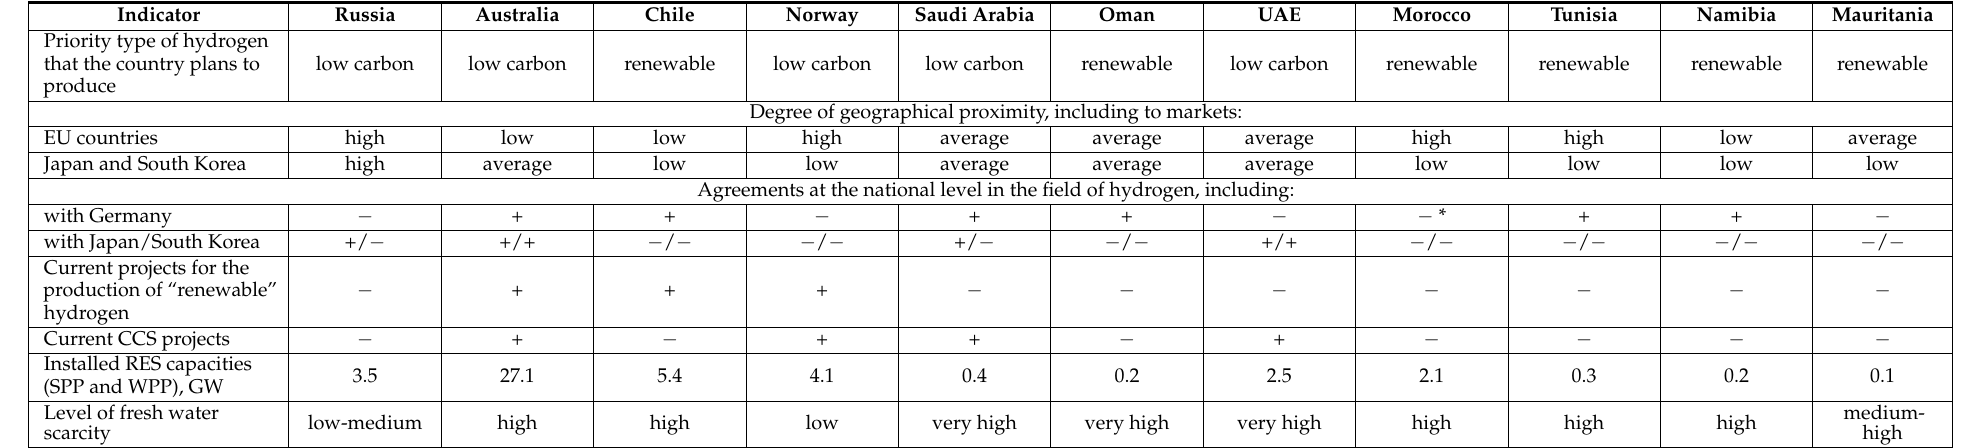
Table 3. Comparison of Russia and its potential competitors in the export of